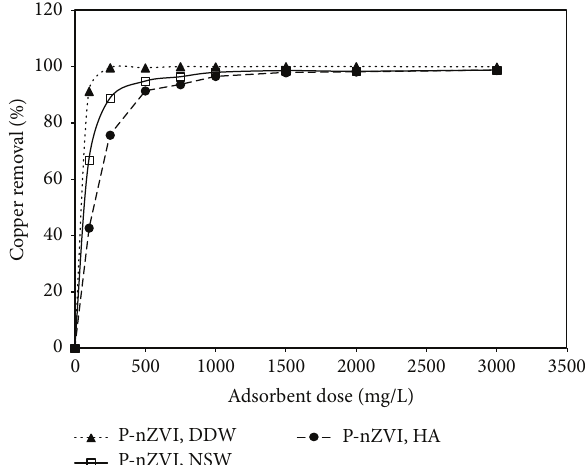
Figure 7: The effect of impurities of solution on copper removal (equilibriumtime:4 h;temperature:20 ∘ C;shaking:150 rpm;pH:8.0; copper concentration: 3000